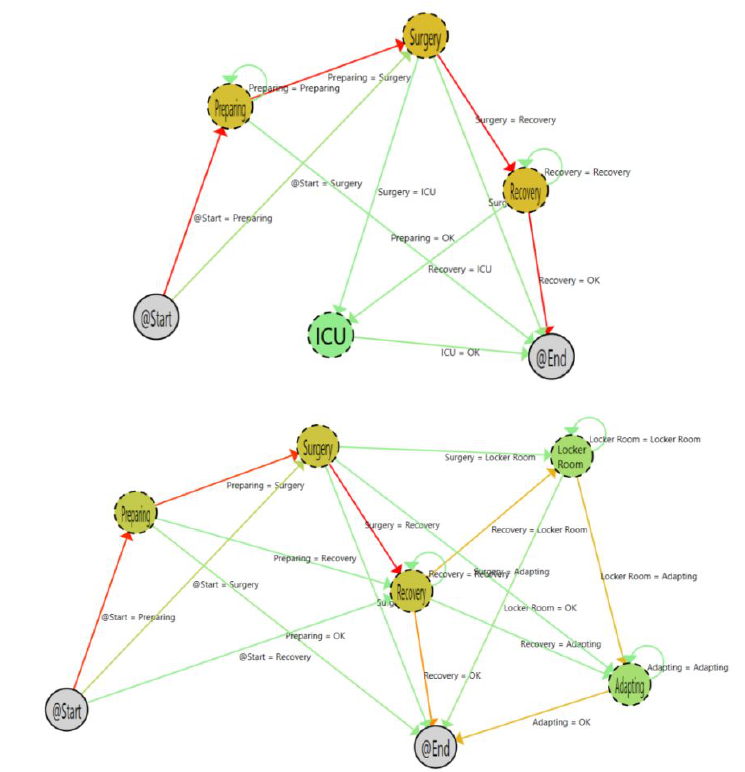
Figure 2. Example of the inferred and enhanced work flows of patients across the operating room service